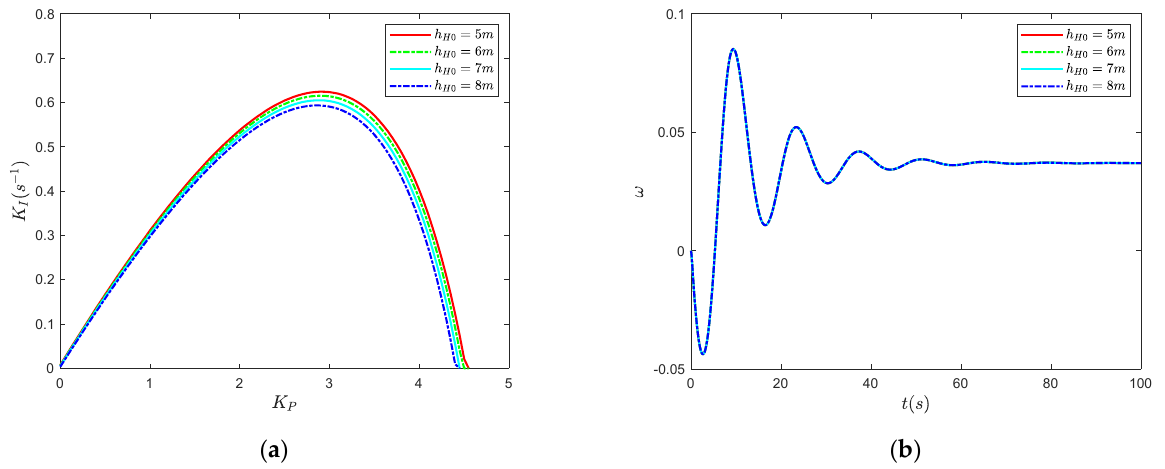
Figure 11. Effect of h H 0 on stability and dynamic characteristics: ( a ) Stable region; ( b ) Dynamic response.